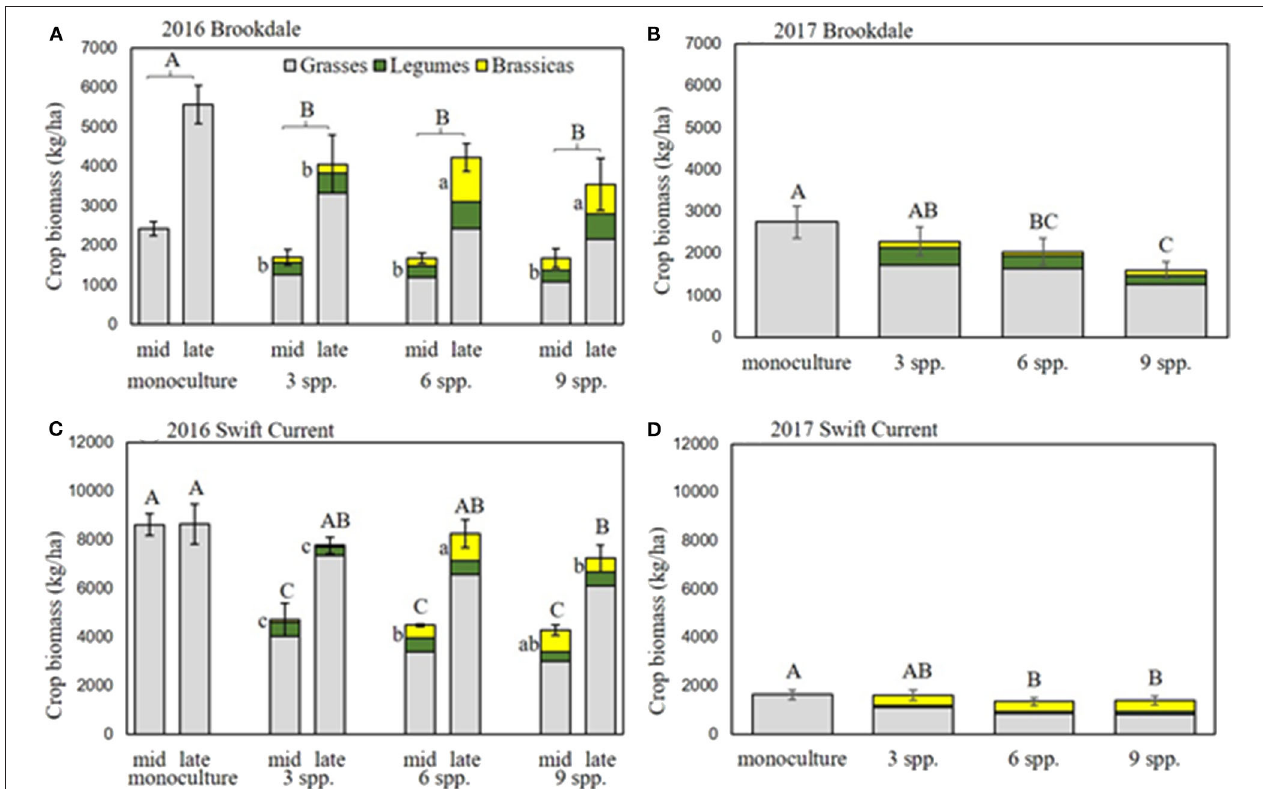
FIGURE 1 | Crop biomass production at Brookdale in (A) 2016 and (B) 2017 and at Swift Current in (C) 2016 and (D) 2017. Mid and late-season crop biomass are presented separately for eco-site years that had a significant mixture by date interaction (i.e., Brookdale 2016 for brassica biomass and Swift Current 2017 for total biomass). Bars with different capital letters are significantly different ( p < 0.05) for total biomass, and lowercase letters are significantly different for brassica (yellow portion of bars)